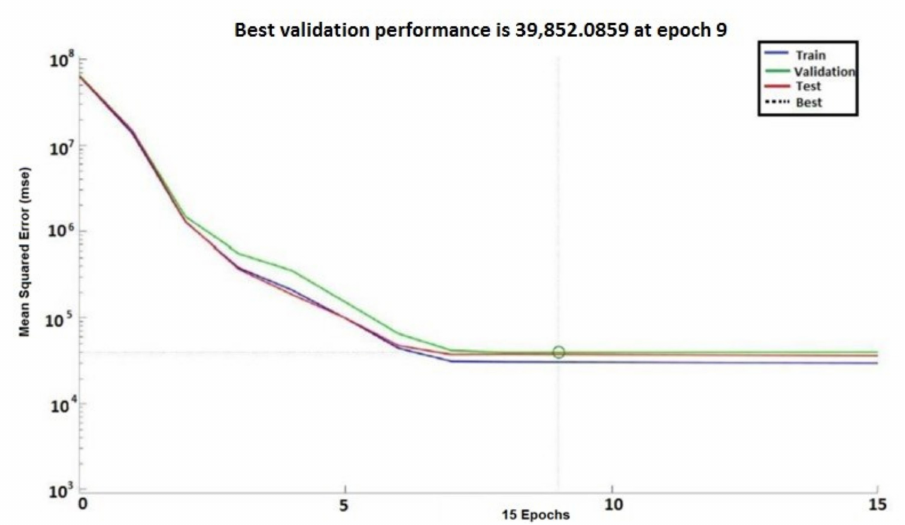
Figure 16. Neural network (150 neurons) best validation